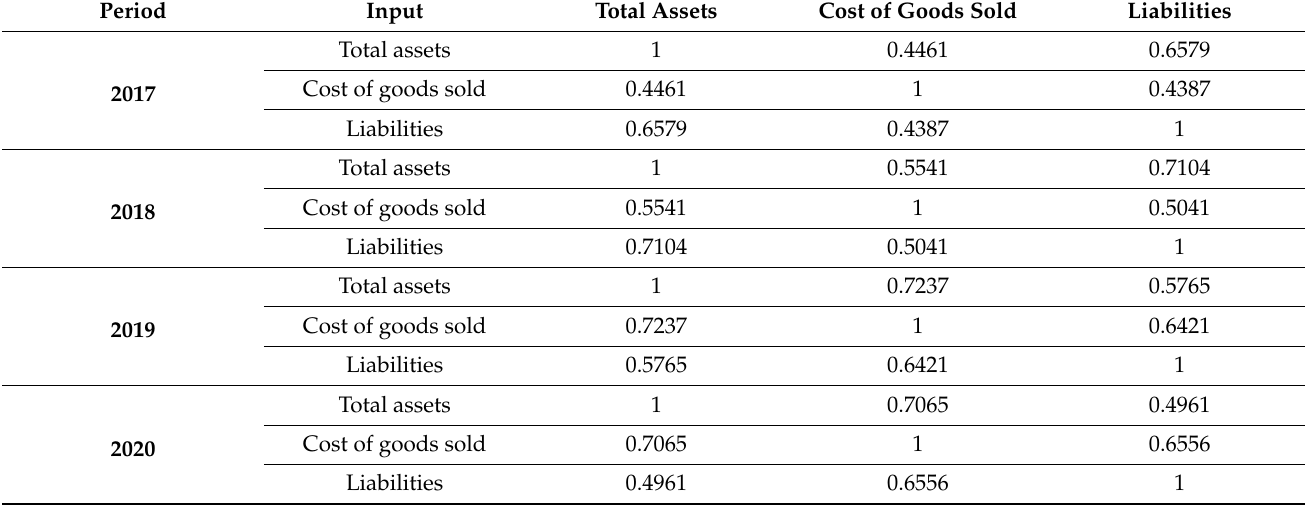
Table 13. Affinity matrix in EBM model (2017–2020).